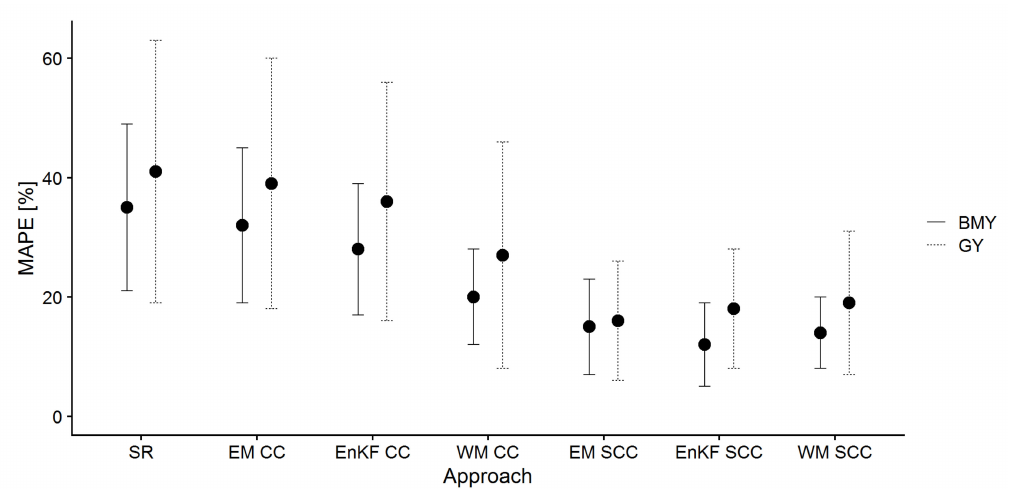
Figure 3. Mean and standard deviation of total aboveground biomass yields (BMY—solid line) and grain yields (GY—dashed line) mean absolute percentage error (MAPE in %) of 14 sites per approach. SR: Standard Run, EnKF: Ensemble Kalman Filter, WM: Weighted Mean, EM: Ensemble Mean, CC: Crop Component Set, SCC: Soil and Crop Component